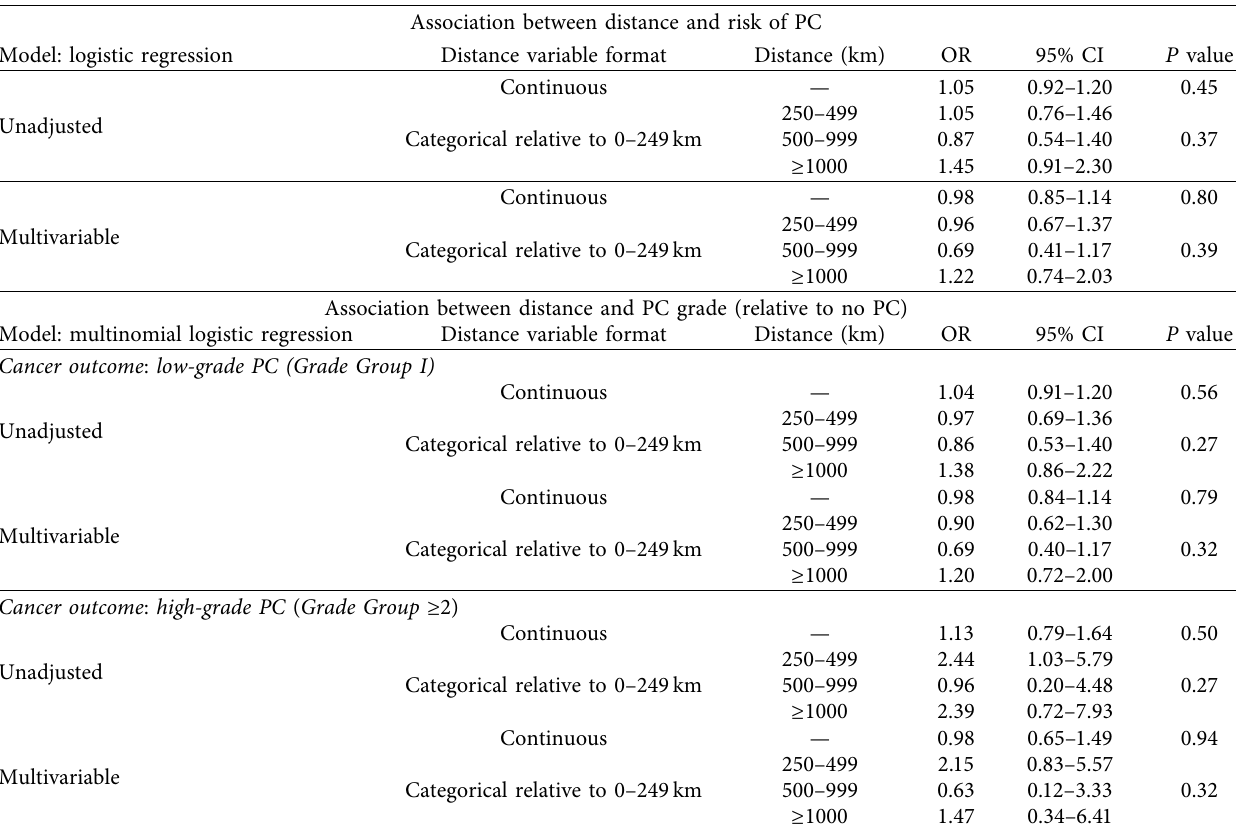
Figure 2: LOWESS smoothened curve evaluating the univariable association between distance to biopsy referral site and compliance. Table 3: The association between distance and risk of PC and PC grade ( n �